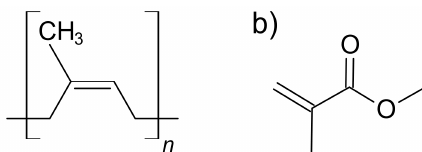
Figure 1. Chemical structures of ( a ) polyisoprene (NR) and ( b ) methyl methacrylate (MMA).